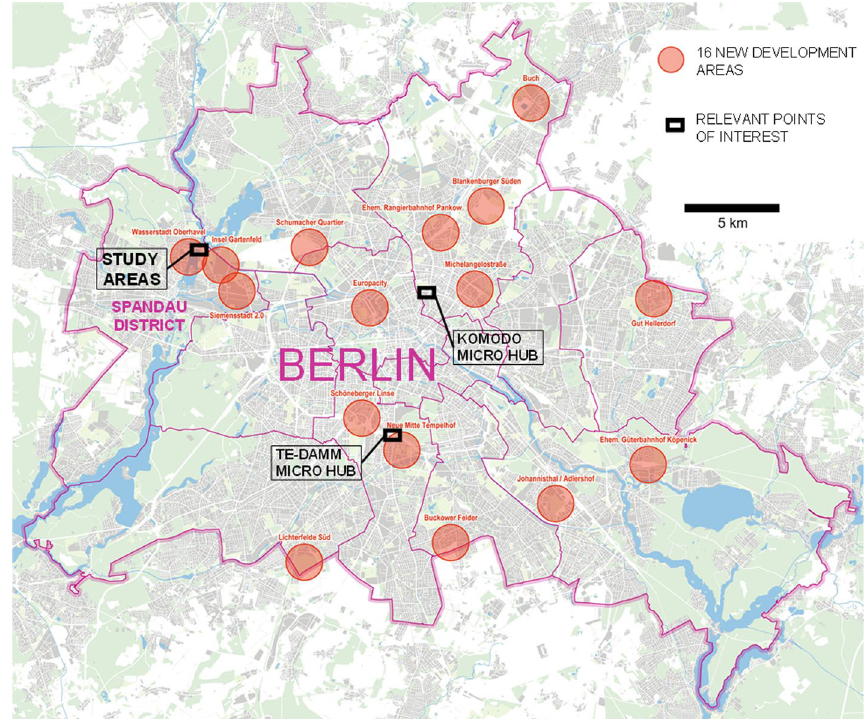
Fig. 1 Map of new residential development areas and relevant points of interest in Berlin (based on Berlin 2019,